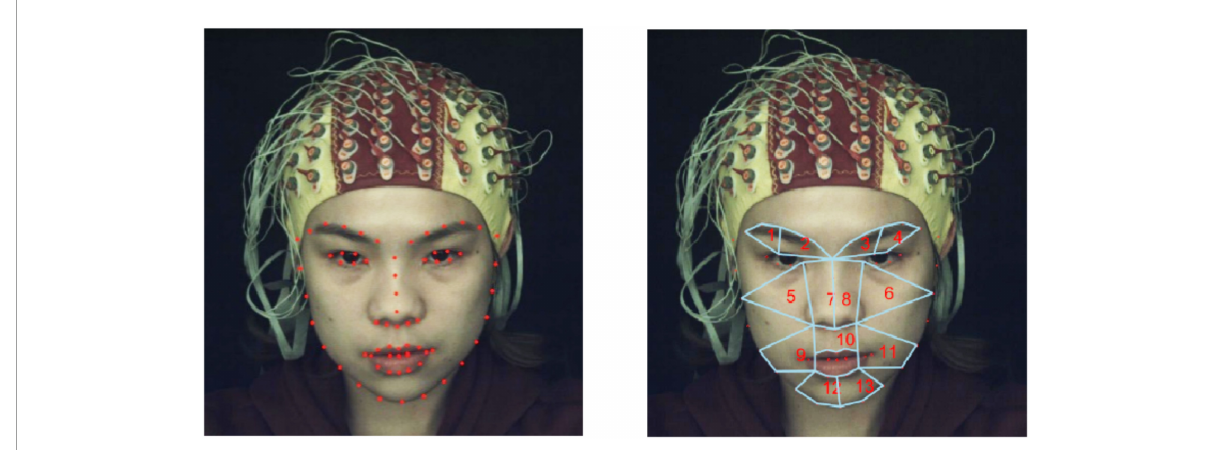
FIGURE2 (Left) Detection of 68 feature points in facial regions using Dlib. (Right) Partitioning of 13 ROIs.